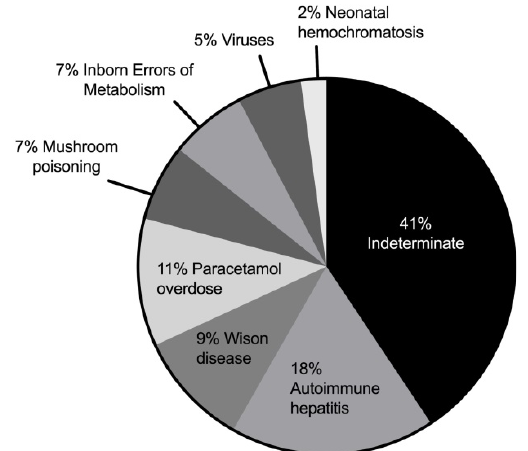
Figure 1. Aetiology distribution of a cohort of 90 Italian children presenting with acute liver fail-